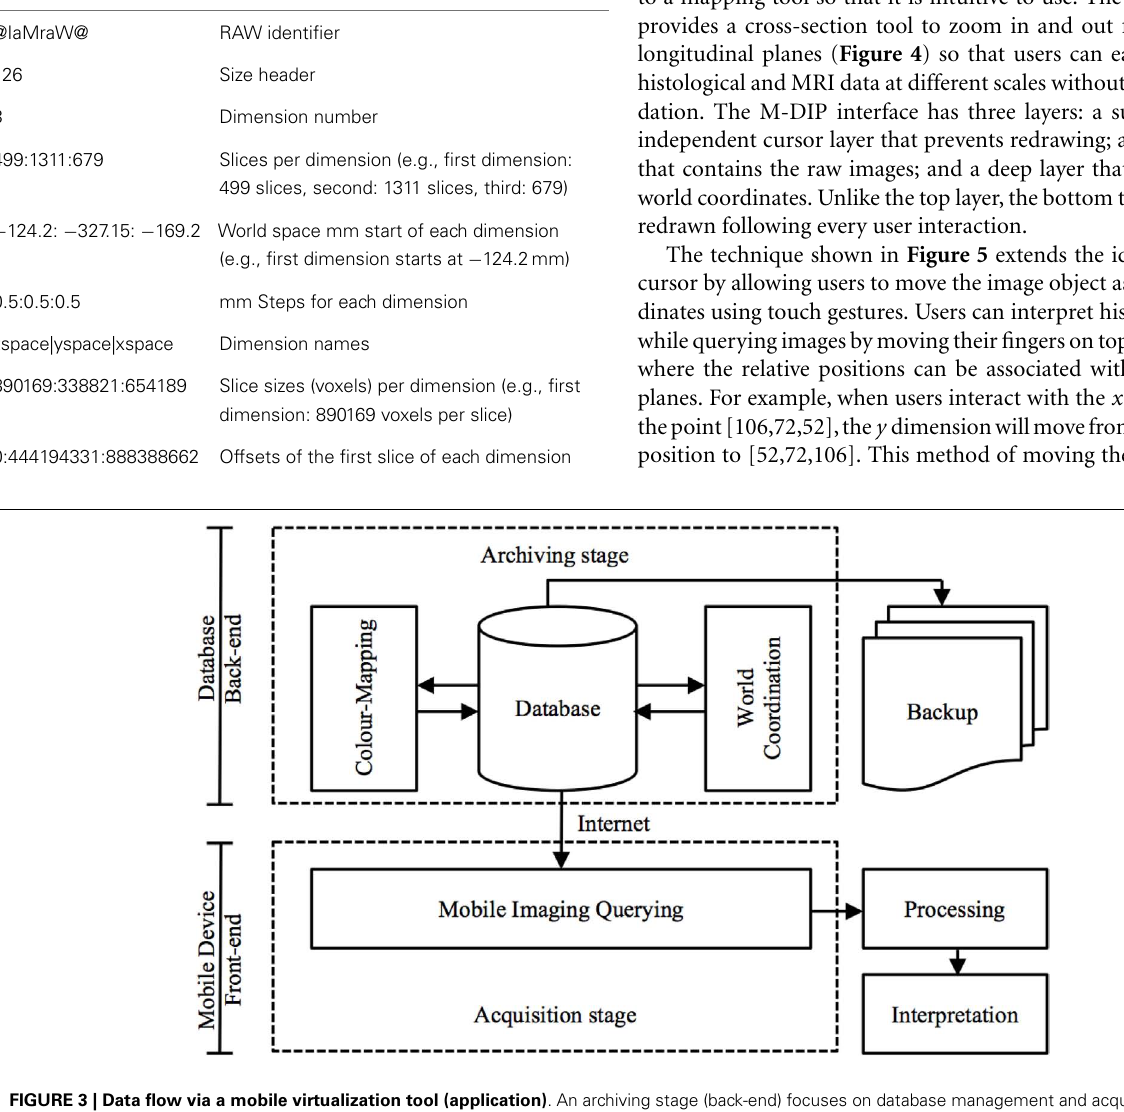
FIGURE 3 | Data flow via a mobile virtualization tool (application) . An archiving stage (back-end) focuses on database management and acquisition stages (front-end) handle image-querying and